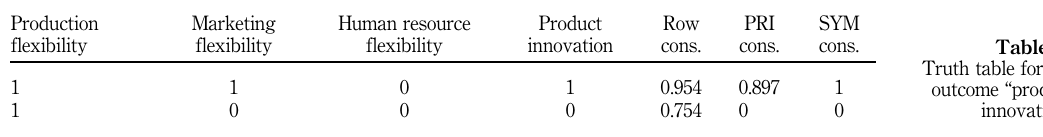
Table II. Truth table for the outcome “ product innovation